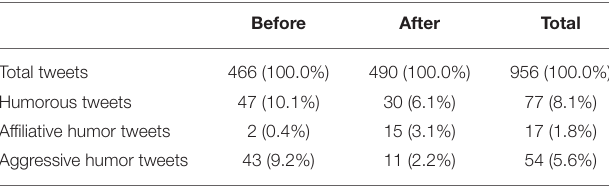
Frontiers in Sociology |